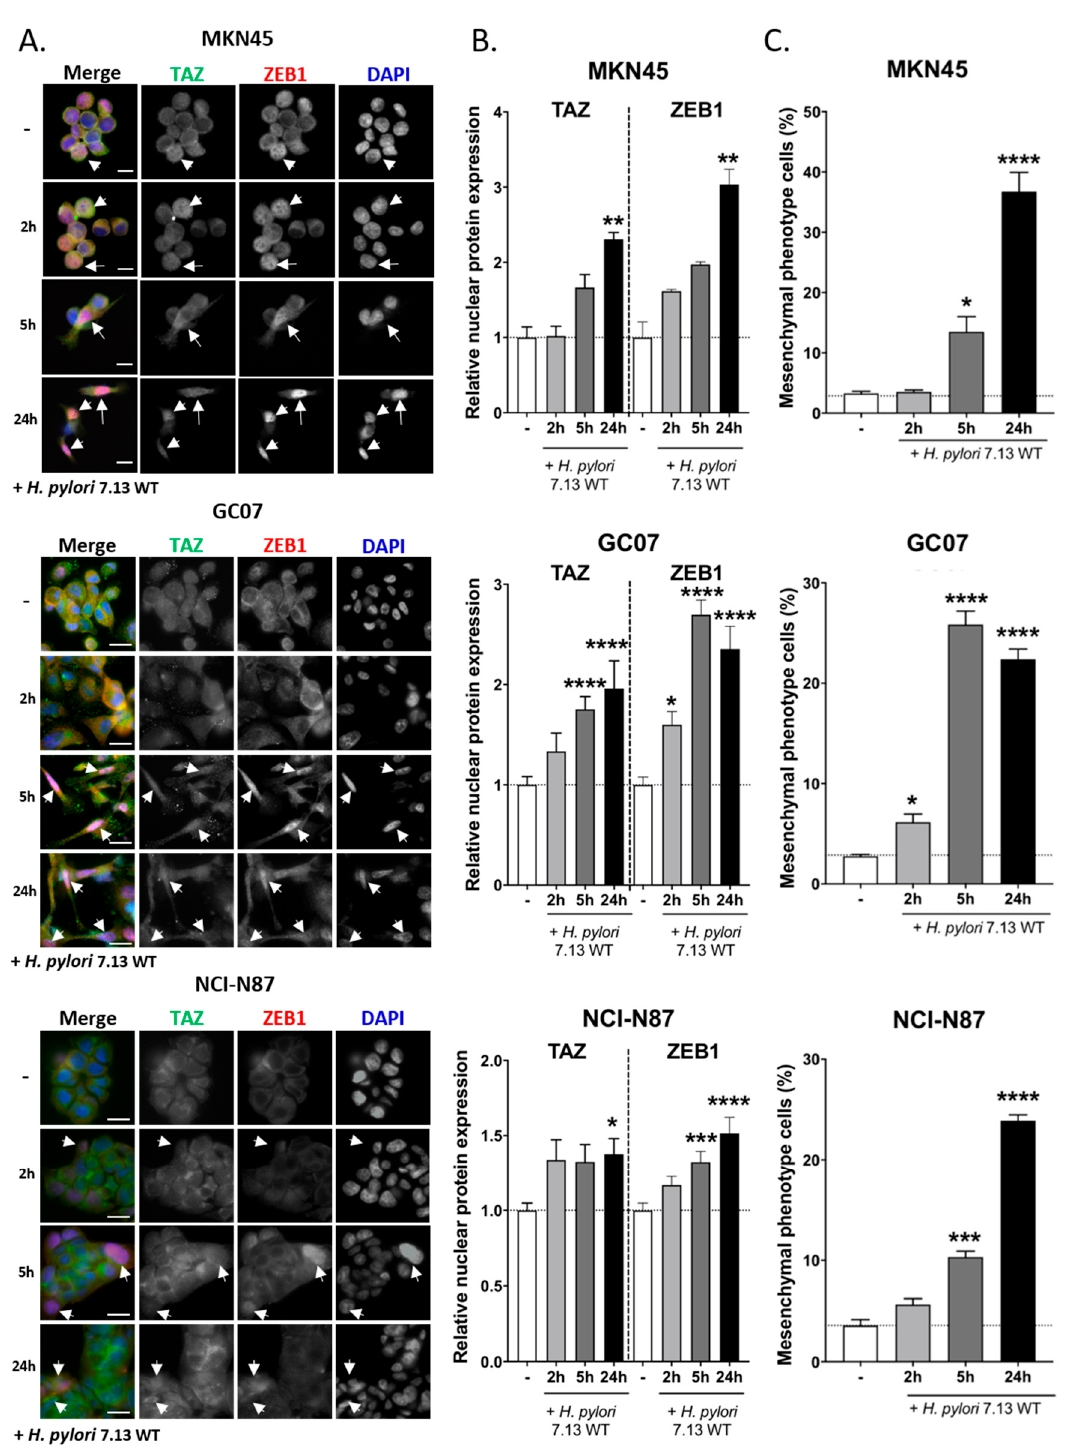
Figure 2. H. pylori induced TAZ and ZEB1 co-upregulation associated with their nuclear translocation. ( A ) Expression and subcellular localization of TAZ and ZEB1 assessed by immunofluorescence during the time-course of infection with 7.13 WT H. pylori strain. Representative immunofluorescence images of TAZ (in green), ZEB1 (in red), and nuclei stained with DAPI (in blue) in MKN45, GC07, and NCI-N87 cells. Bars scale, 10 µ m. White arrows show TAZ and ZEB1 co-accumulation in the nuclei. ( B ) The relative amount of TAZ and ZEB1 nuclear accumulation was quantified by the number of positive-